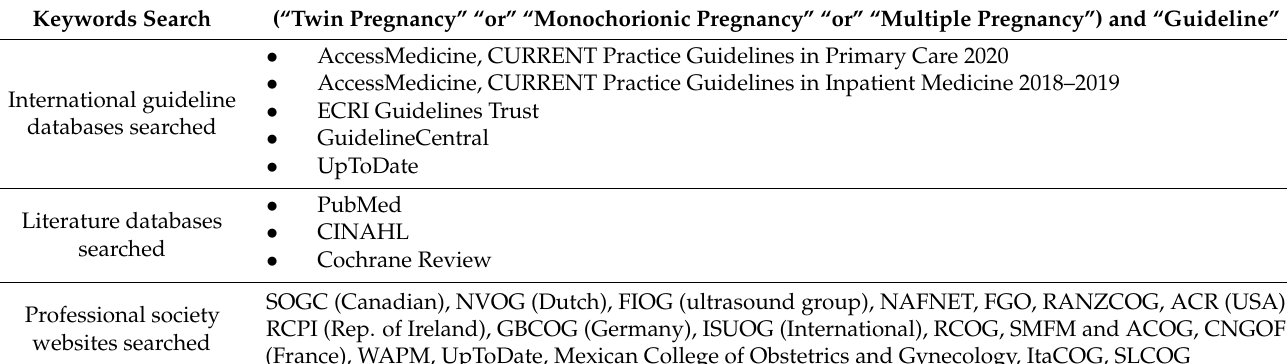
Table 1. Guideline Search